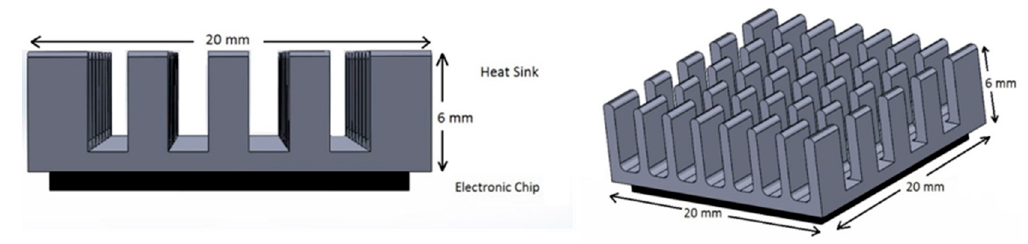
Figure 1. SolidWorks drawing of the simulated Heat Sink.